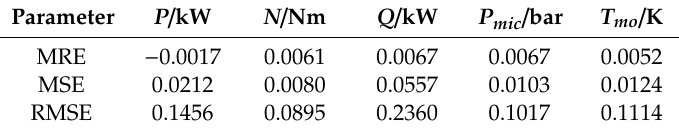
Table 9. The MRE, MSE, RMSE of the data.